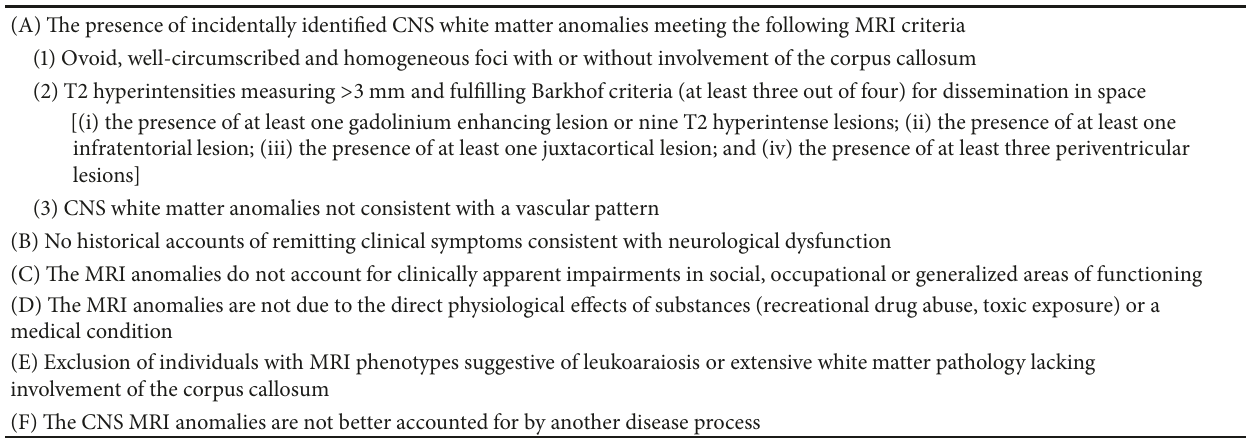
Table 1: Proposed diagnostic criteria for radiologically isolated syndrome